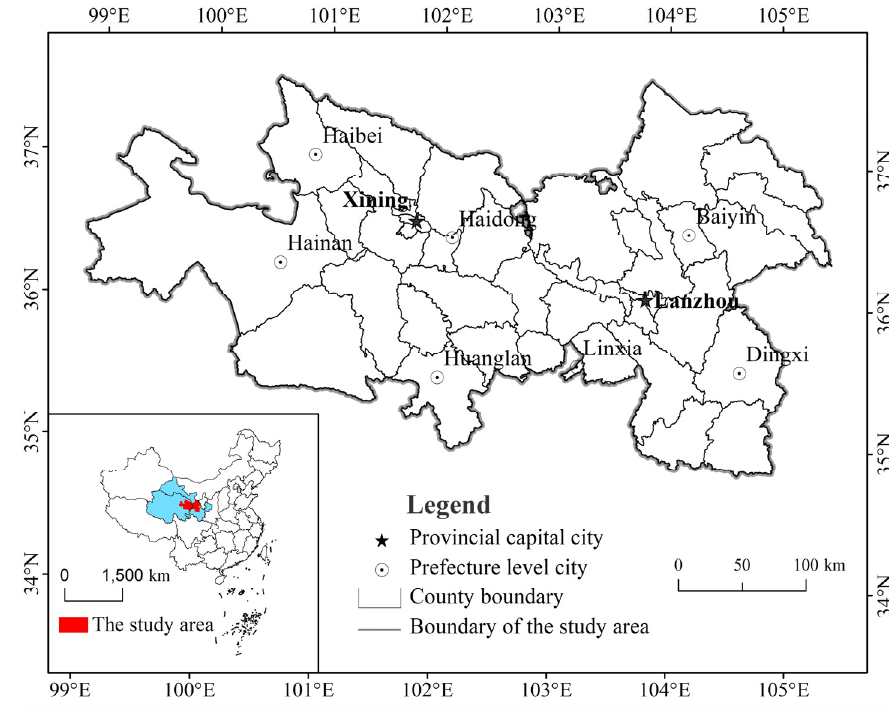
Figure 3. Study area.